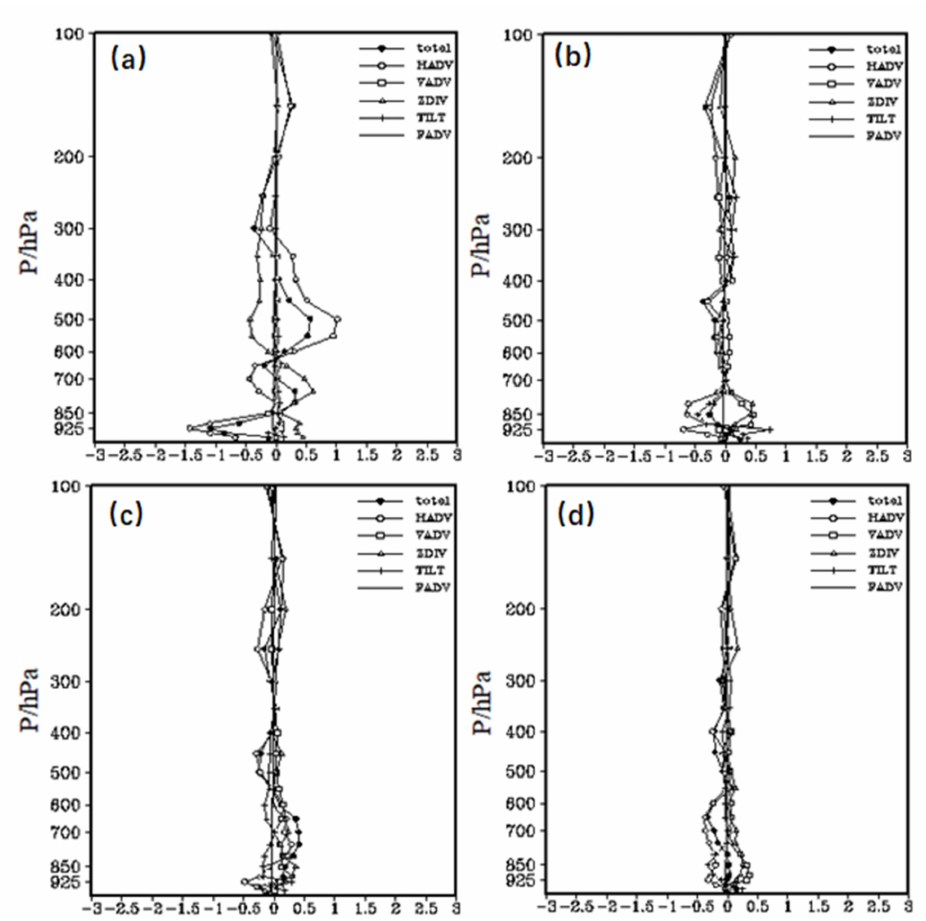
Figure 11. Simulated vertical distribution of each term of vorticity equation (unit: 10 − 8 s − 2 ) averaged in the region (29–31 ◦ N, 121–124 ◦ E) after closing the latent heat release of the inner 3 km grid on 4–5 August 2020. ( a ) 20:00 BT 4, ( b ) 02:00 BT 5, ( c ) 05:00 BT 5, ( d ) 08:00 BT